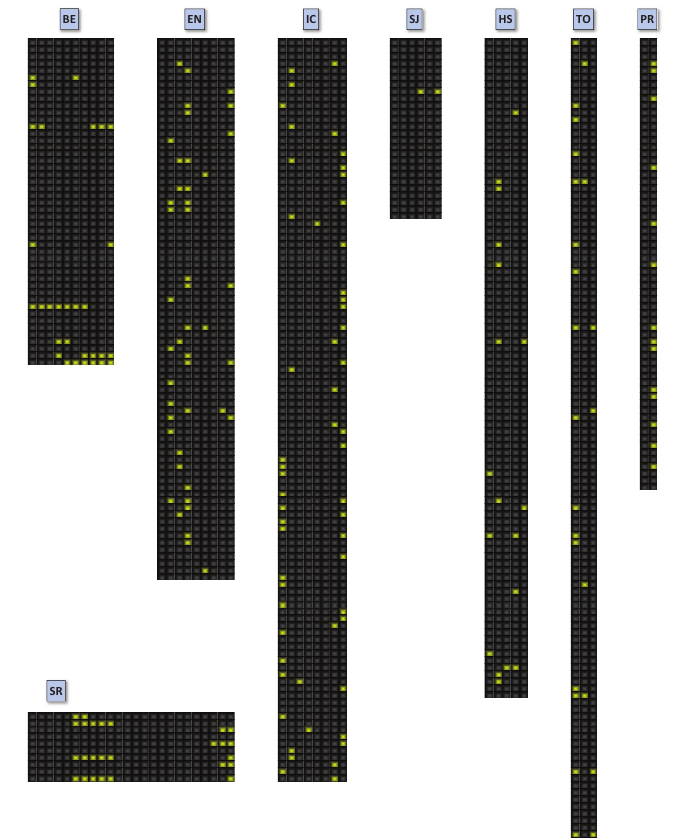
Figure 6. A variety of the characteristics of the datasets. The unknown performances are